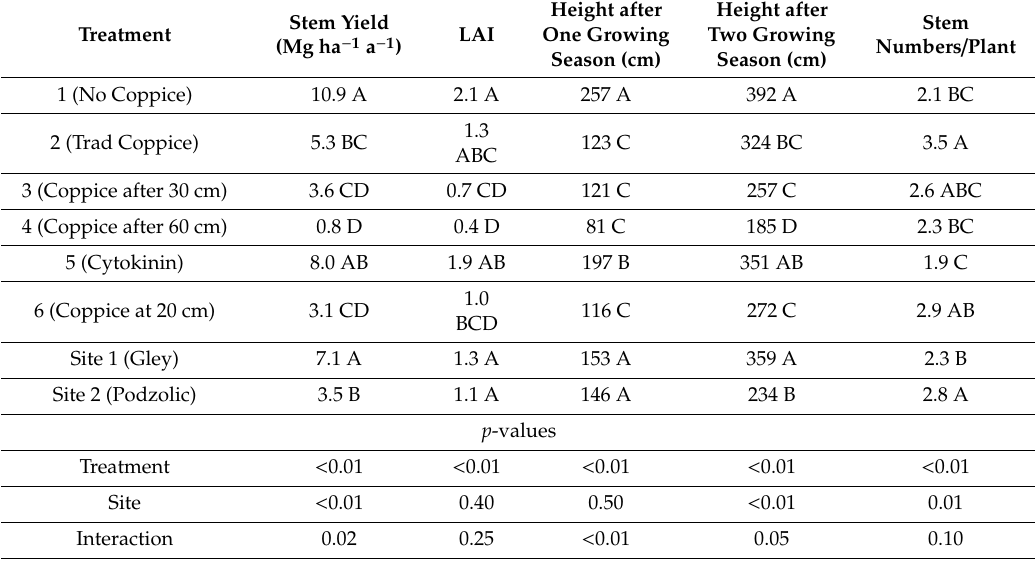
Table 7. Stem yield (represented as dry matter tonnes per hectare measured two growing seasons), Leaf Area